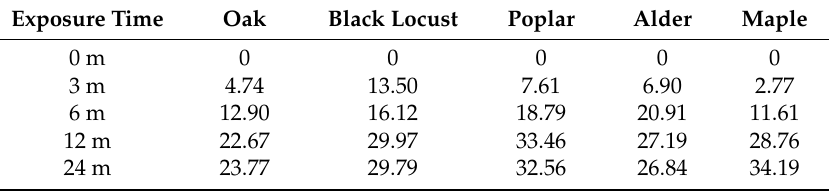
Table 7. Exposure time-dependence of ∆ E * value. The data represent mean values. Exposure Time